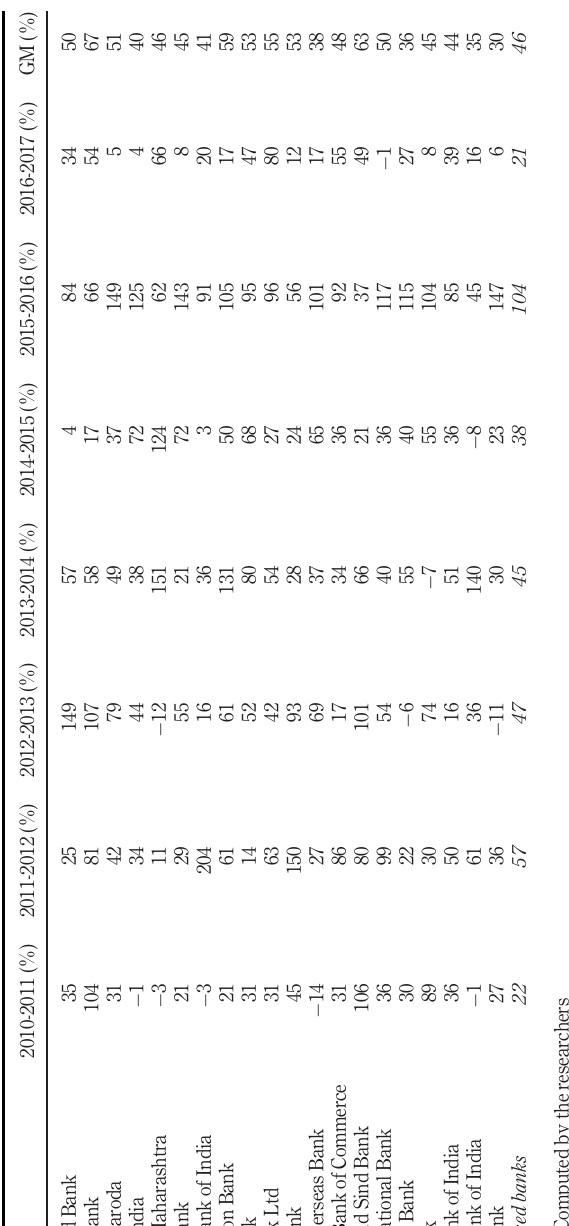
Table V. Year on year growth rate in gross NPAs in nationalised